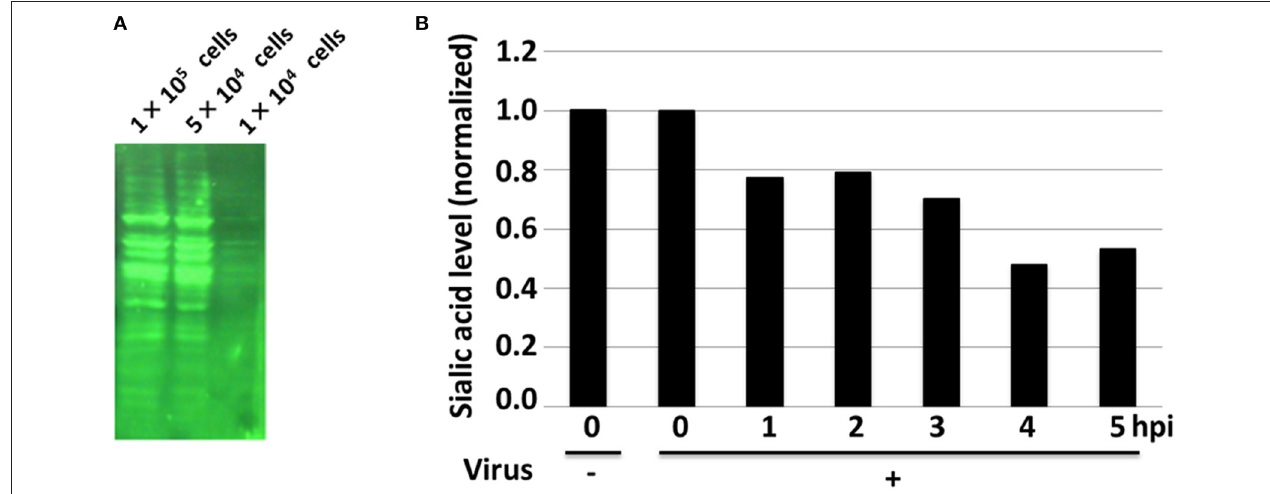
FIGURE 1 | The Western blot analyses of extracted α -2,6-sialic acids visualized using tagged-SNA lectins. (A) Western blotting with different numbers of cells was performed to determine the optimal, non-saturating signals. (B) The quantification of the normalized chemiluminescence signals of the sialic acids are shown. Result for the control without viral infection (–) is also shown and the data set was normalized to the control.